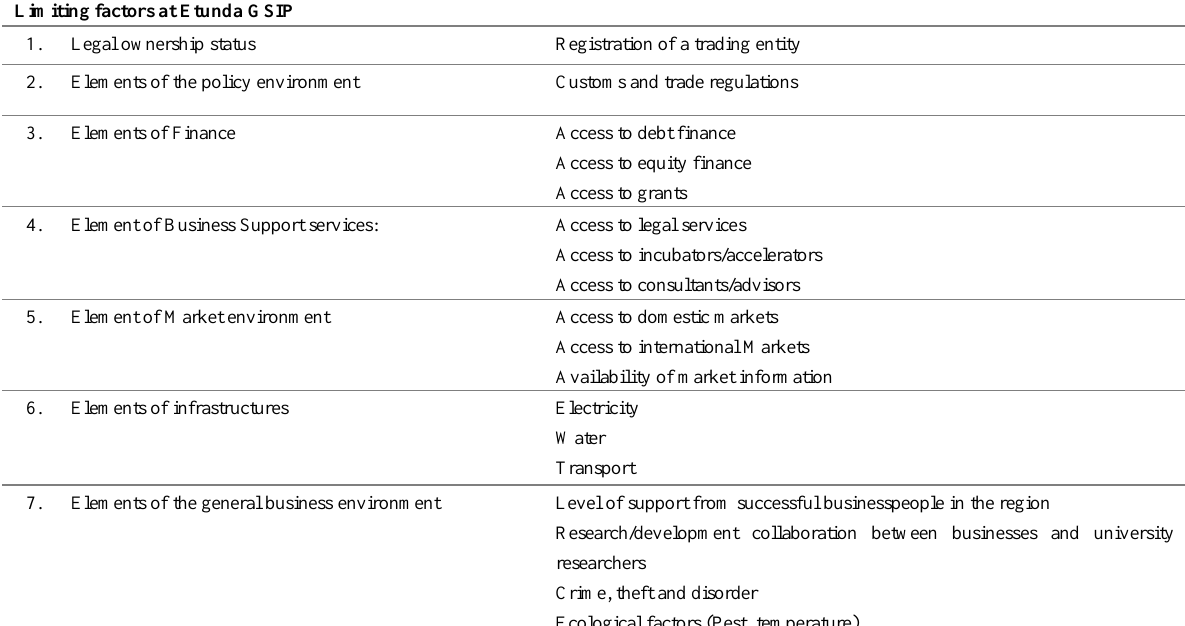
Table 2: Limiting factors affecting SSIF entrepreneurship action at Etunda